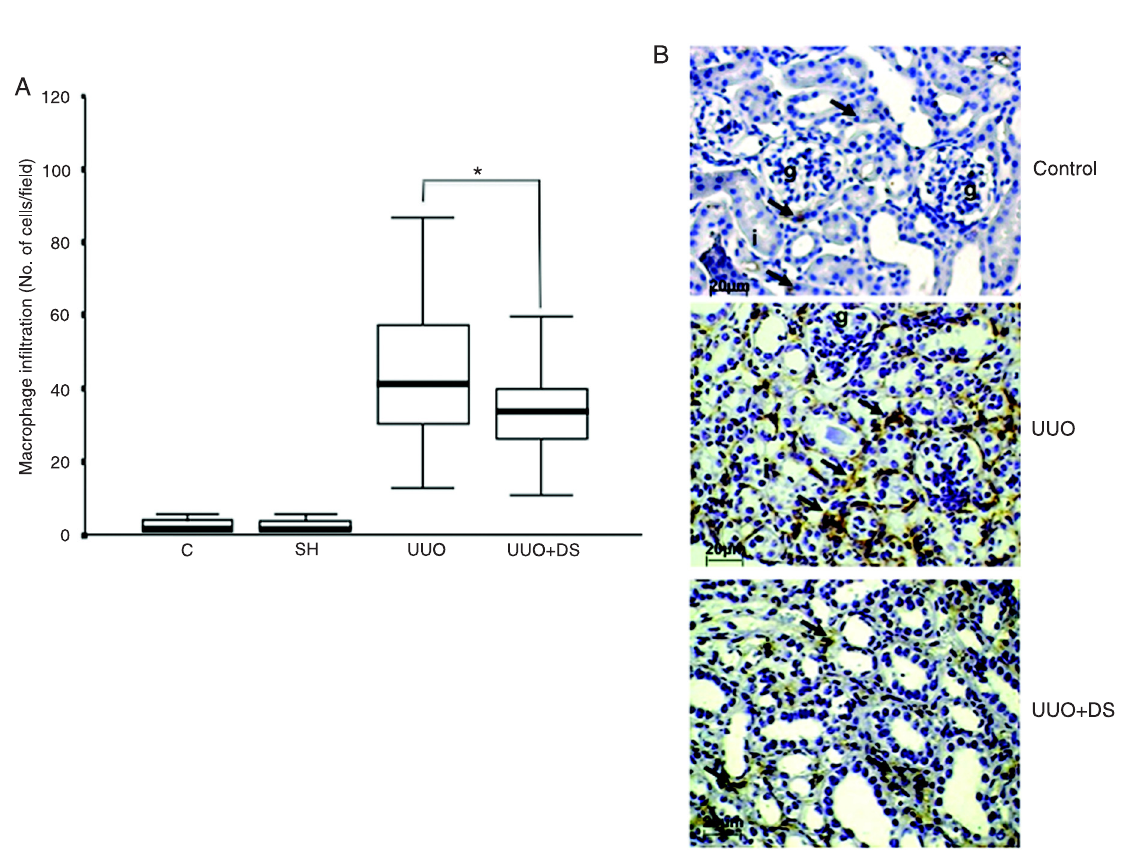
Figure 4. Macrophage infiltration into the kidney of mice submitted to different treatments. A , Macrophage infiltration was estimated by immunohistomorphometry of F4/80-positive cells in sections of kidneys of mice from group C (control kidney), group SH (sham-oper- ated kidney), group unilateral ureteral obstruction (UUO), and group unilateral ureteral obstruction plus dermatan sulfate (UUO+DS). Data are reported as means ± SD for N = 6. The boxes represent the 25th and 75th percentiles, and the vertical bars represent the ranges, N = 30. B , The arrows point to strong F4/80-positive cells in the interstitial area compared with those with no staining in control and UUO+DS panels. g = glomerulum; i = interstitium. Scale bar = 20 µm. Magnification 400X. *P < 0.05